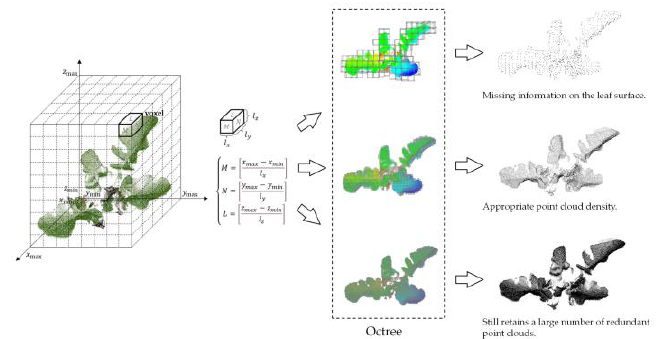
Figure 4. Schematic of voxel filtering algorithm.